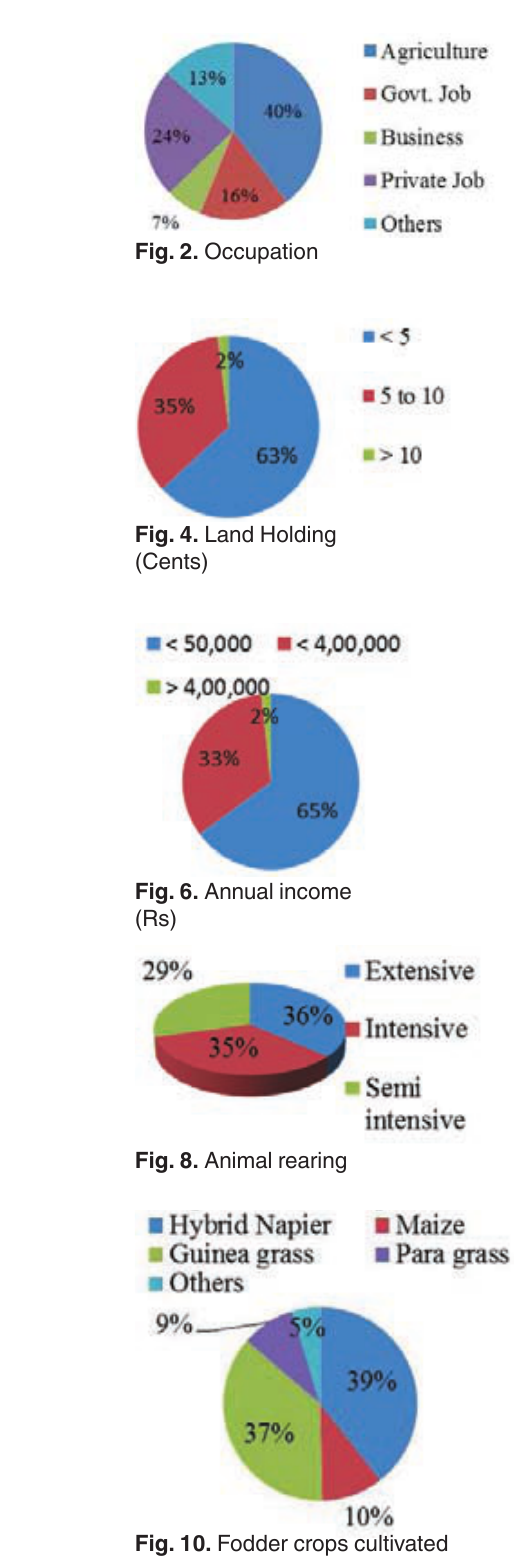
Fig. 10. Fodder crops cultivated